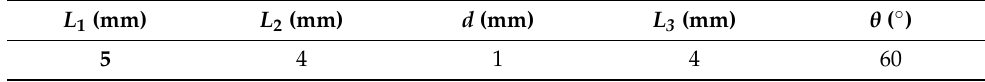
Table 1. The design parameters of the